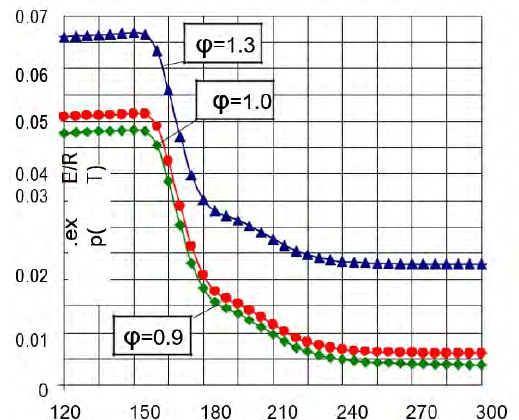
Figure 8. Variation of Xf.exp(-E/RT) in function of crank angle with different equivalence ratio (D20, n=2100rpm)